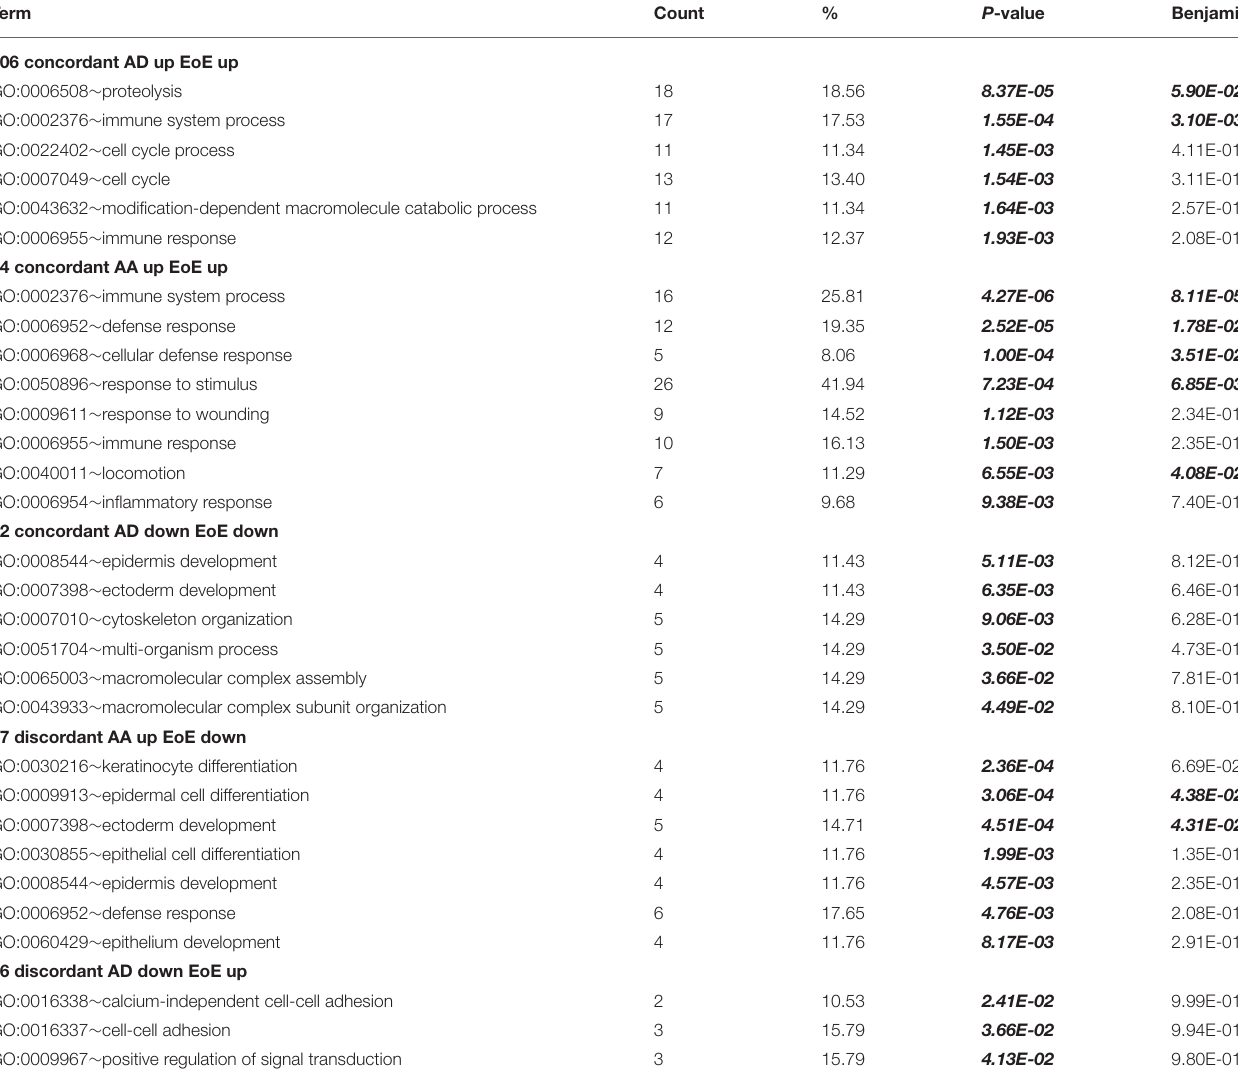
TABLE 1 | Top shared biological processes